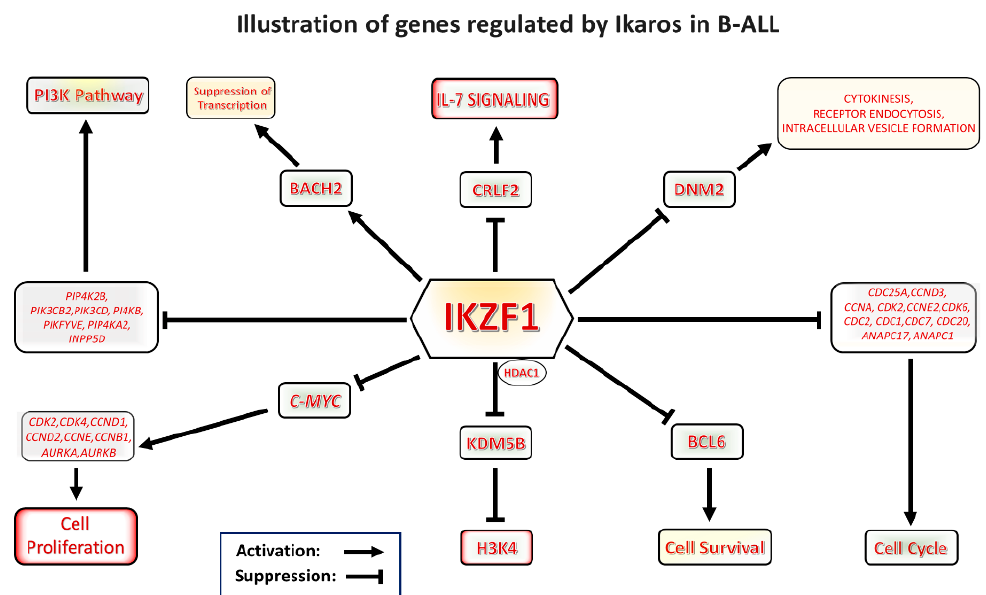
Figure 2. Graphical representation of Ikaros signaling in B-cell acute lymphoblastic leukemia (B-ALL). Ikaros is a master regulator and tumor suppressor which modulates transcription of a number of genes important for leukemogenesis. The drawing illustrates various pathways regulated by Ikaros.